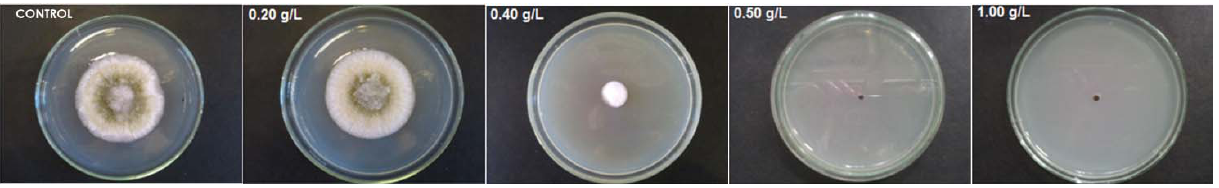
-CH-Pr on the radial growth of 30 80